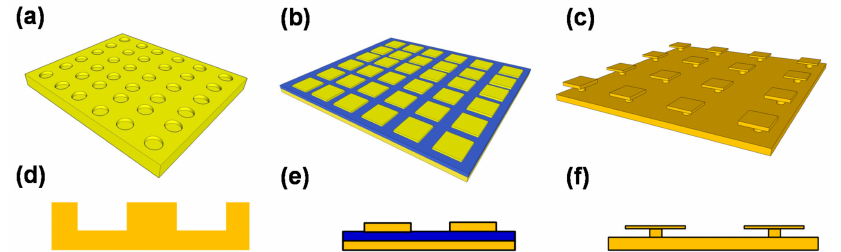
Figure 2. Schematic illustrations of the oblique and cross-sectional views of three types of PMAs: ( a , d ) Crystal-type; ( b , e ) MIM-type and ( c , f ) MR-type